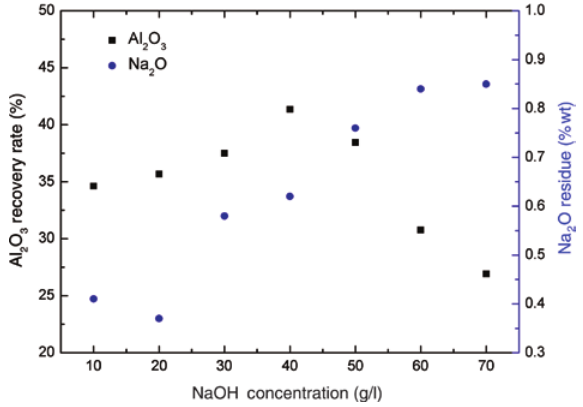
Figure 7: Analysis of final residues produced from the direct process using NaOH solutions of different concentrations.